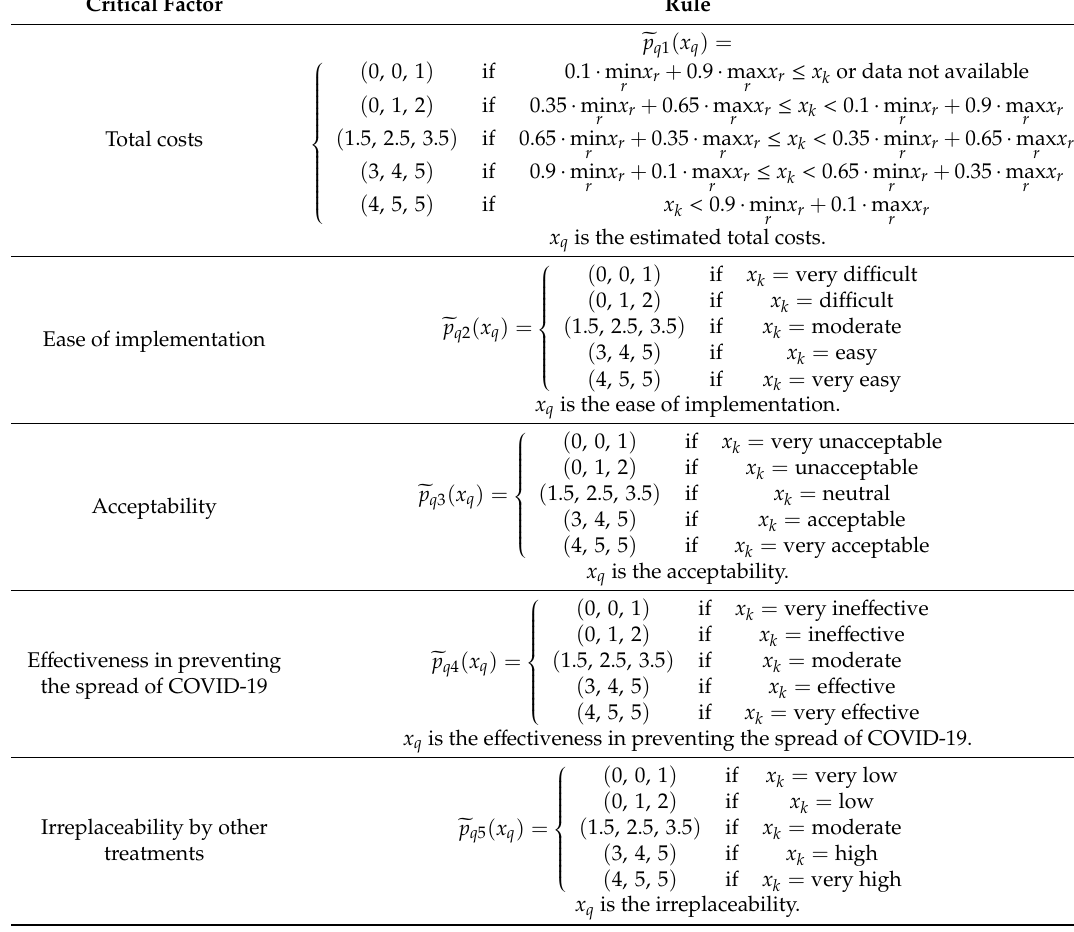
Table 6. Rules for evaluating the performances in optimizing the critical factors. Critical Factor